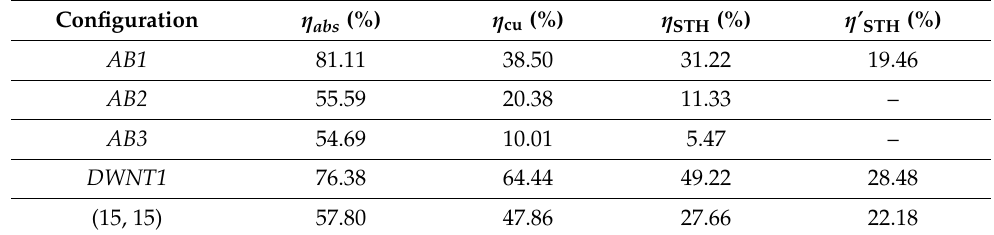
Table 2. For Janus WSSe bilayers with different stacking patterns and Janus WSSe nanotubes ( DWNT1 and (15, 15) SWNT), the Light Absorption Efficiency η abs , Carrier Utilization Efficiency η cu , STH Conversion Efficiency η STH , and Corrected STH Conversion Efficiency η ’ STH